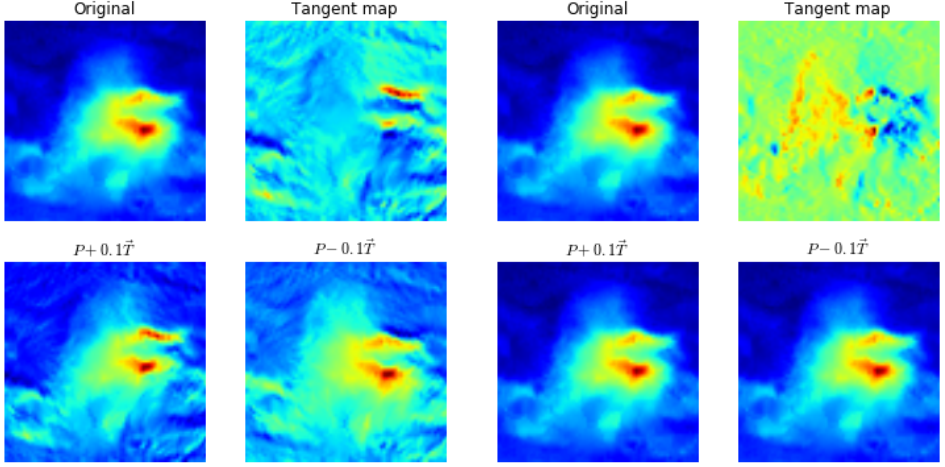
Figure 5. Rotation manifold ( left group ) ; and thickening manifold ( right group ) at “2016-01-19 10:30:00”.